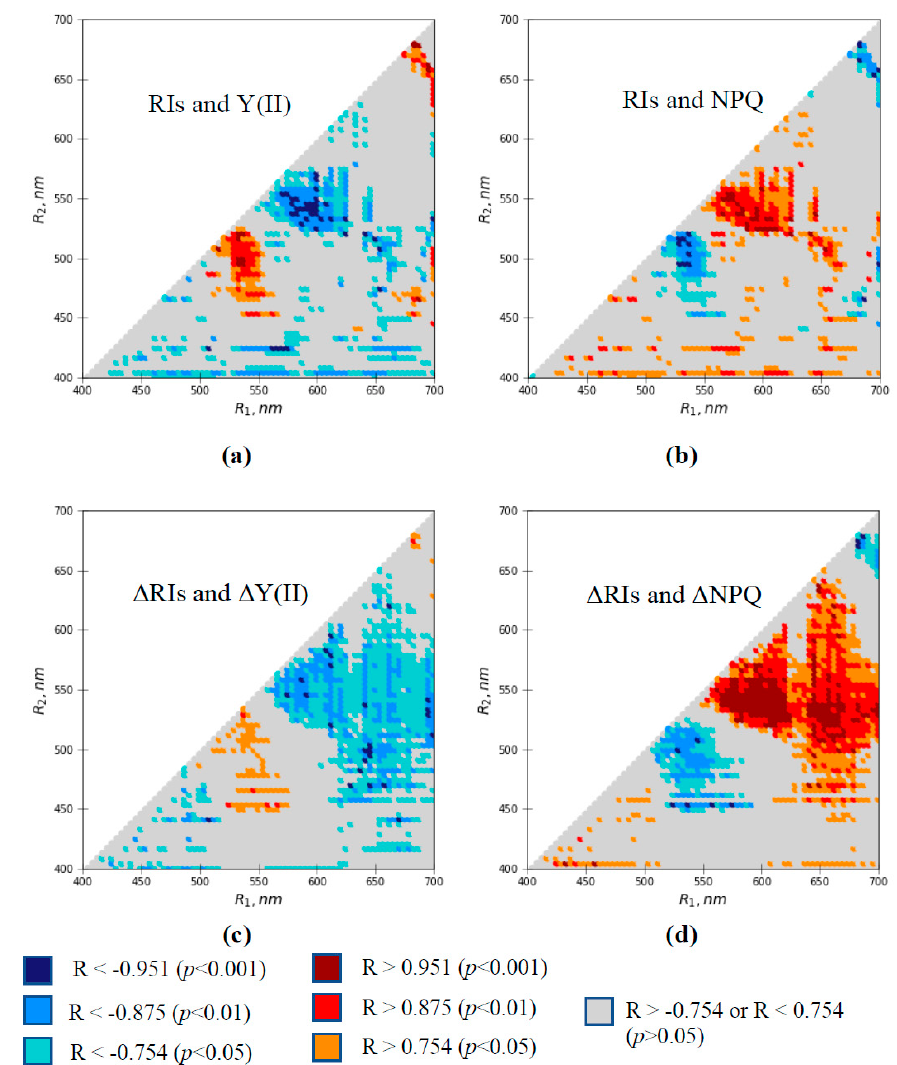
Figure 5. Heat maps of linear correlation coefficients (R) between RIs and Y(II) ( a ), RIs and NPQ ( b ), Δ RIs and Δ Y(II) ( c ), and Δ RIs and Δ Y(II) ( d ). Pearson’s correlation coefficients were calculated based on medians of investigated parameters. The medians were calculated for each time point ( n = 7). Only significant correlation coefficients are shown in the figure. Areas of the spectral regions with a significant correlation of Δ RIs with Δ Y(II) and Δ NPQ were larger than the areas with a significant correlation of RIs with Y(II) and NPQ.